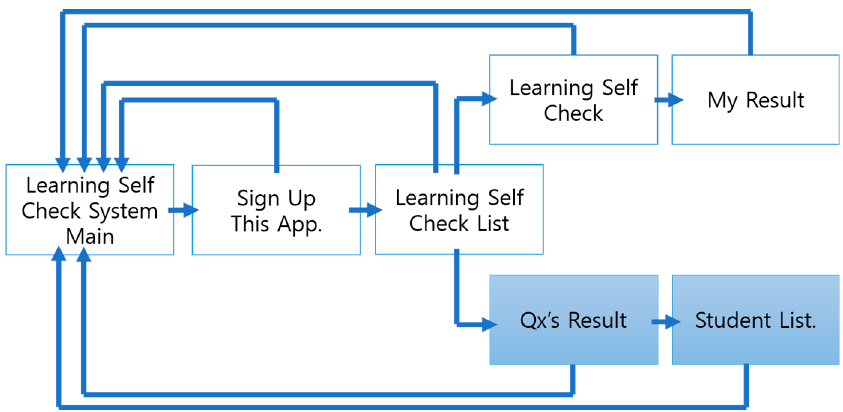
Figure 2. Design for menu architecture of mobile application.